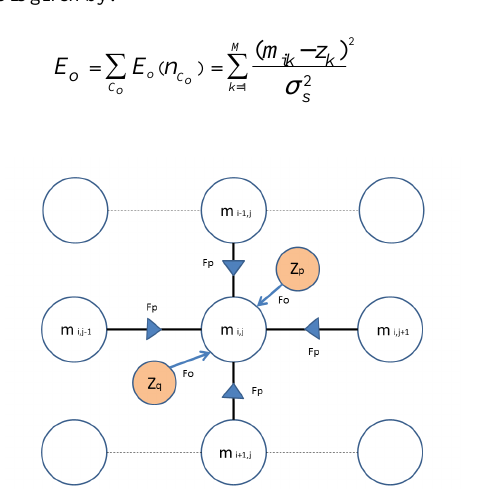
Figure 1. Factor graph corresponding to 4-neighbourhood scheme for a grid point at row i and column j. Two types of nodes: estimated elevation at grid points (m) and observed elevations (z). They affect central cell estimate depending on prior factors (F p ) and observation factors (F o )